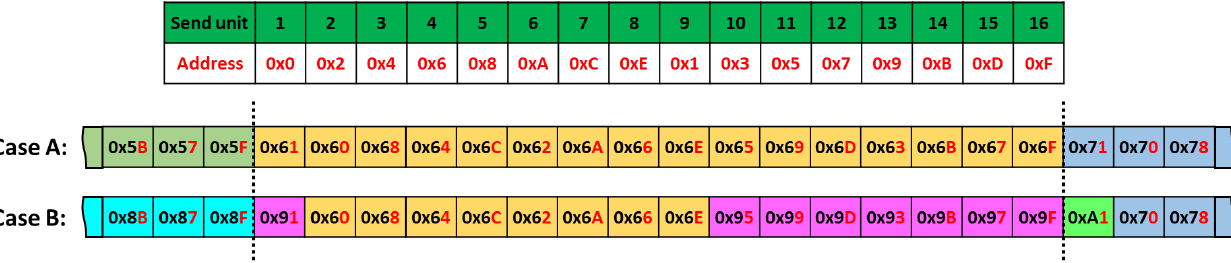
Figure 14. Readout experience data obtained in case A and in case B. The order in which the data are extracted from the sensor is related to the priority imposed by the FPA tree.